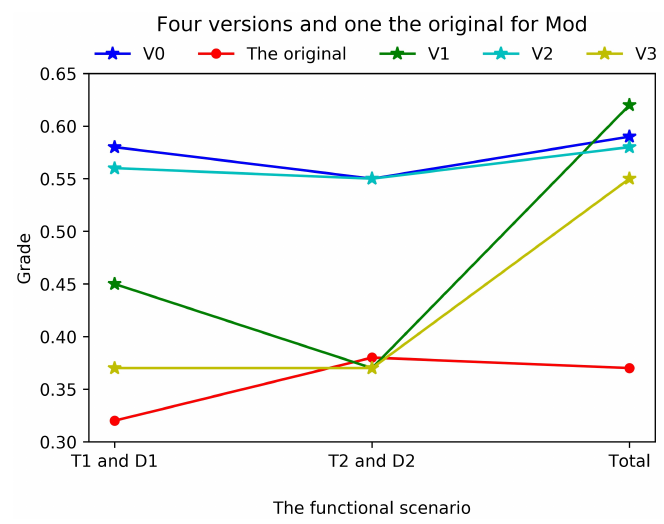
Figure 6. Results by four versions and the original for